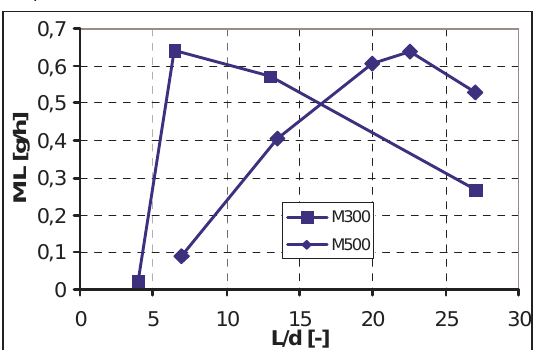
Fig. 12. Measured mass losses for 2 orifices and hydraulic power 180